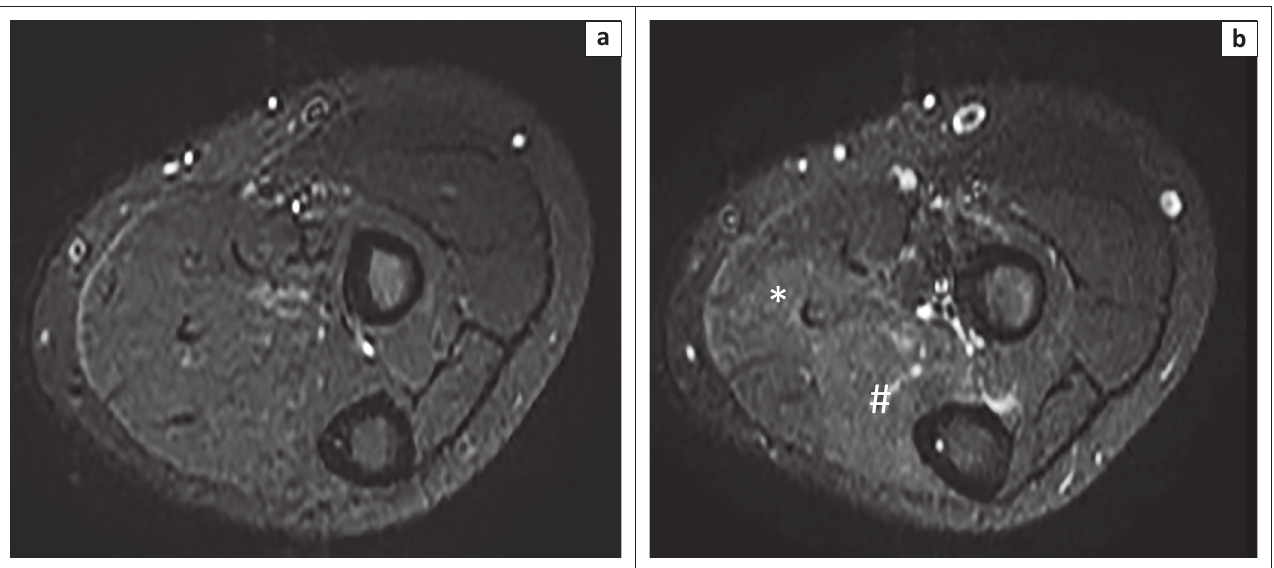
FIGURE 2: Signal intensity ratio plotted per data record.